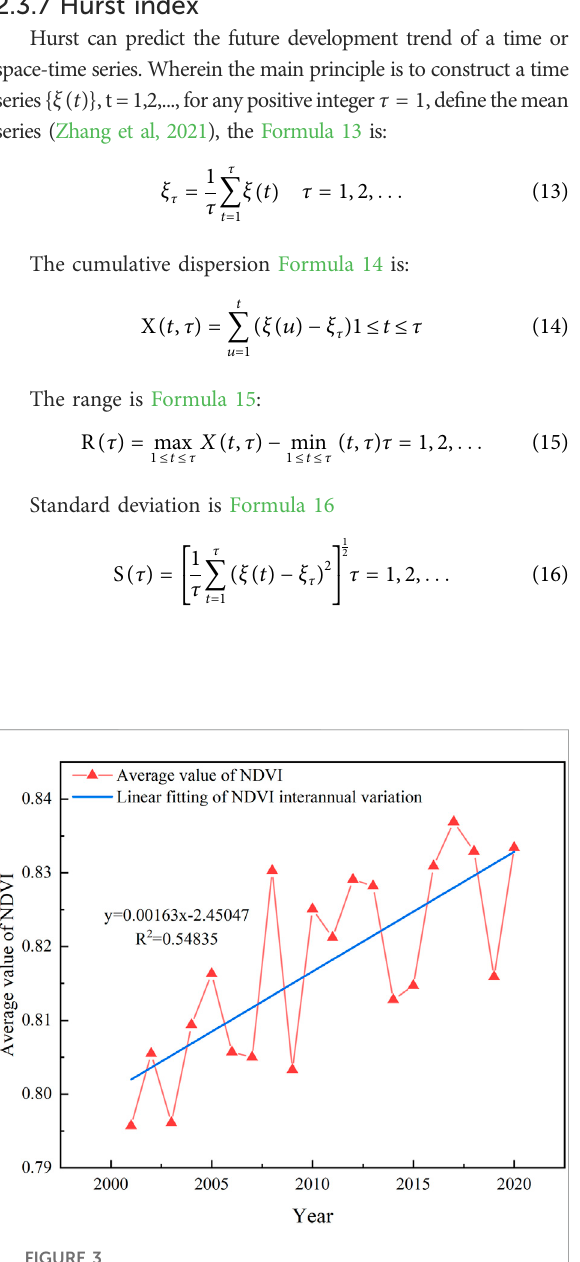
FIGURE 3 NDVI change trend of annual average vegetation in the three northeast provinces from 2001 to 2020.